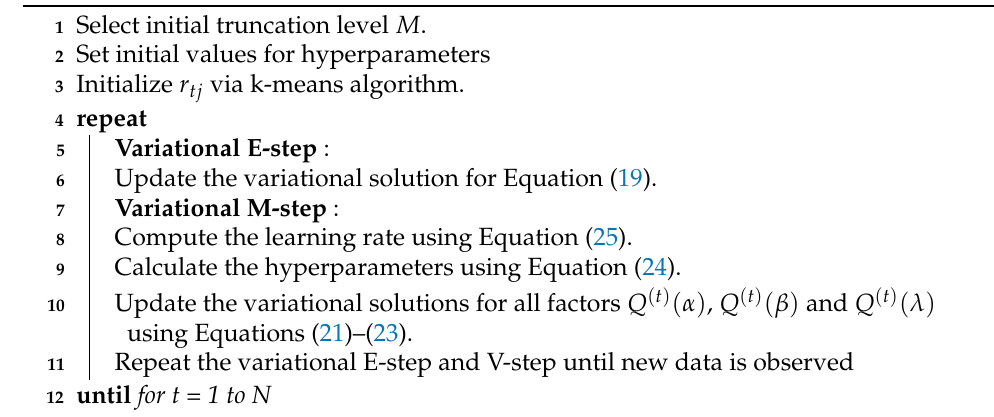
Algorithm 2: Proposed online algorithm for